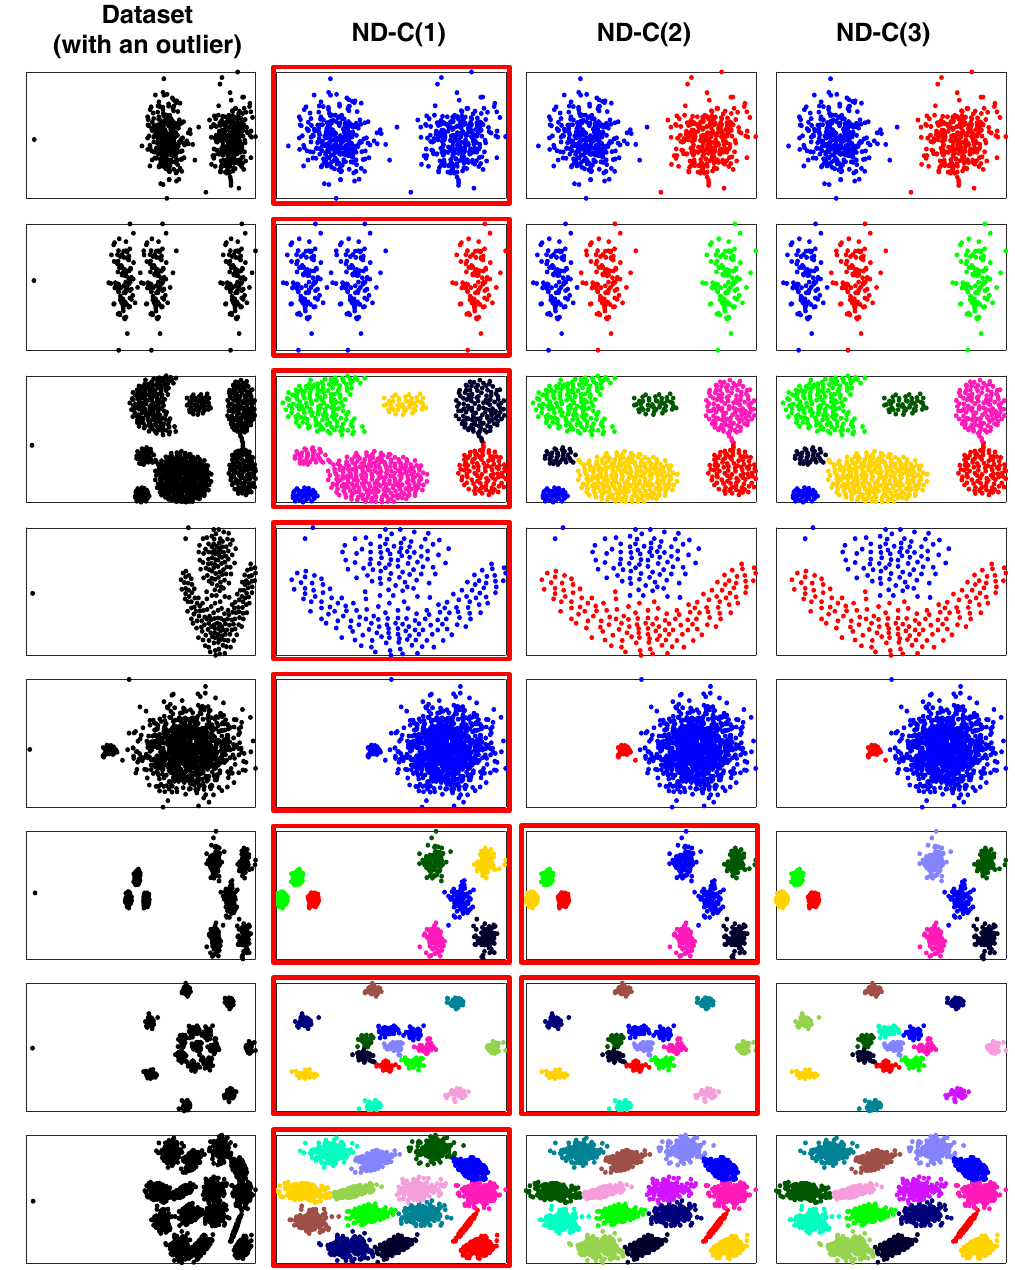
Figure 8. Comparison of clustering performance of ND-C(1), ND-C(2), and ND-C(3) on the outlier- contaminated datasets. The subplots within the red rectangles are the ones containing obvious false assignments. In each subplot (in columns 2, 3 and 4), different colors on points indicate different clustering assignments on